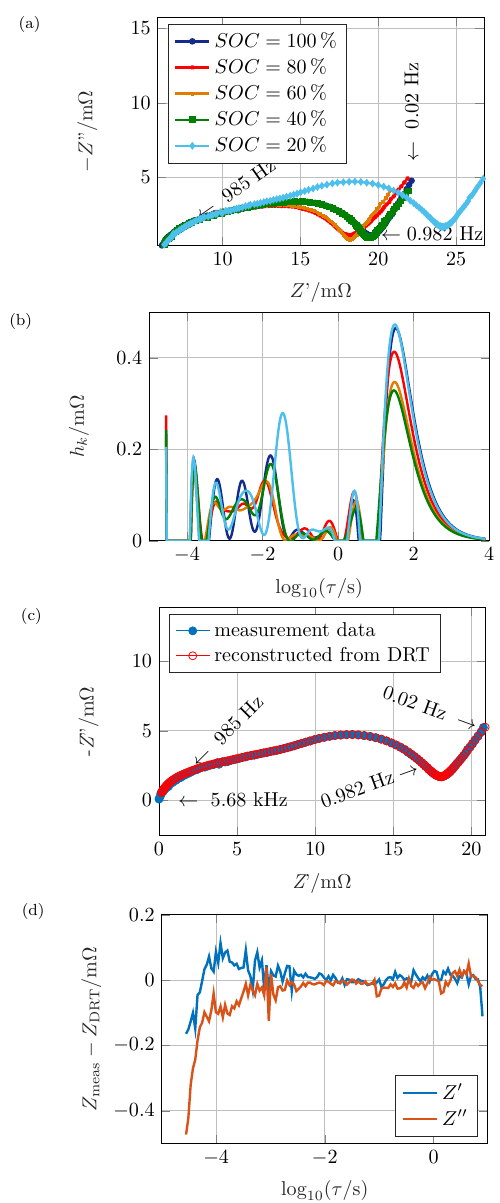
Figure 7. ( a ) Measured impedance spectra of commercial High Energy-NMC cell at varied SOC s (frequencies correspond to 100% SOC , ( b ) non-normalized distribution of time constants, ( c ) measured and reconstructed impedance spectrum for 20% SOC , ( d ) absolute residual between measured and reconstructed impedance for 20% SOC